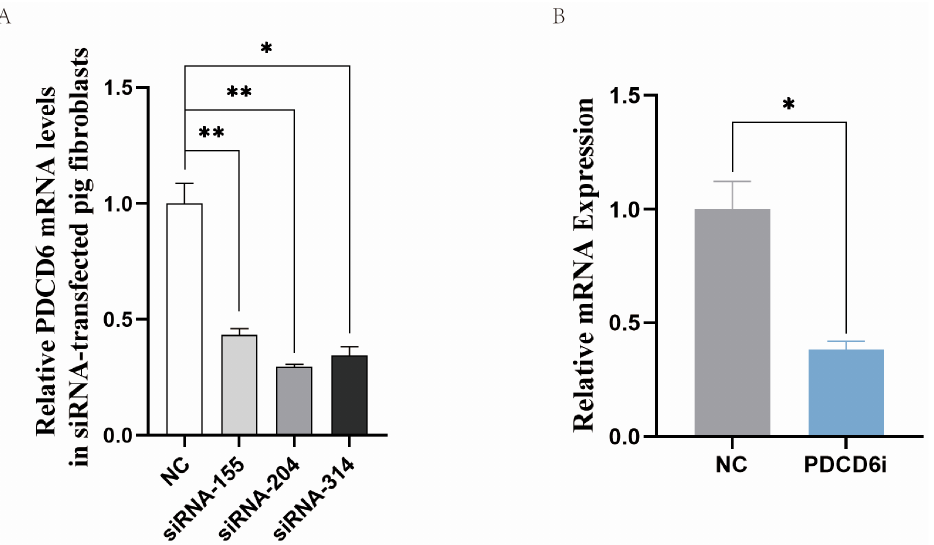
Figure 4. Inhibition of PDCD6 expression in porcine fibroblasts and cloned embryos via RNA interference. ( A ) Selection of effective PDCD6 siRNAs in porcine fibroblasts. siRNA-155, siRNA-204, and siRNA-314 are three different PDCD6 siRNAs. ( B ) Inhibition of PDCD6 expression in cloned pig embryos by microinjection of siRNA-204. PDCD6 i represents PDCD6 siRNA. Quantitative polymerase chain reaction was used to measure the expression levels of PDCD6 at the two-cell stage of the cloned porcine embryos injected with PDCD6 siRNA. NC, negative control siRNA. “*” and “**” represent a significant difference at p < 0.05 and p < 0.01, respectively. Table 3. The effects of PDCD6 siRNA microinjection on the in vitro developmental efficiency of pig SCNT embryos.